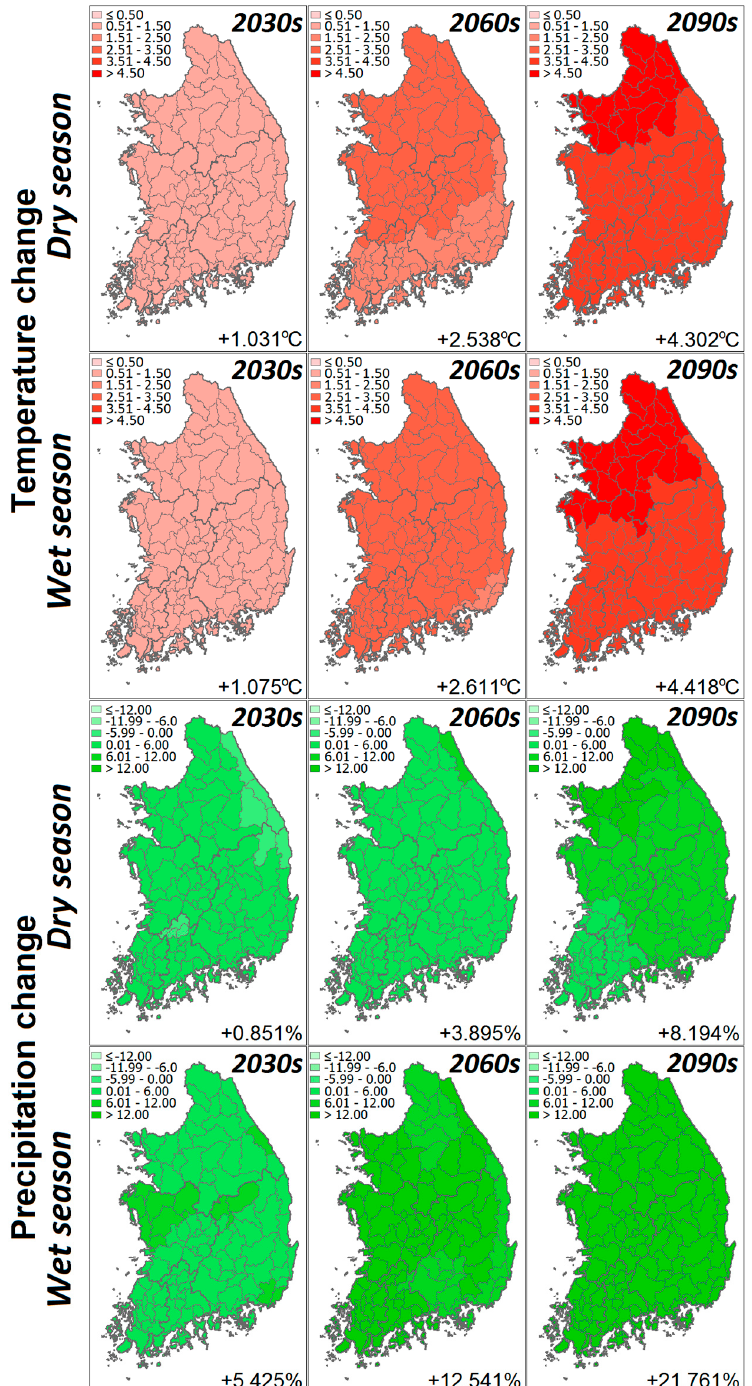
Figure 4. Spatial distribution of changes in temperature (°C) and precipitation (%) in 3 future periods (2010–2039, 2040–2069, and 2070–2099) referred to the baseline (1976–2005) in South Korea during the dry and wet seasons in RCP 8.5. The values show the MME means of downscaled results averaged for 109 subbasins.